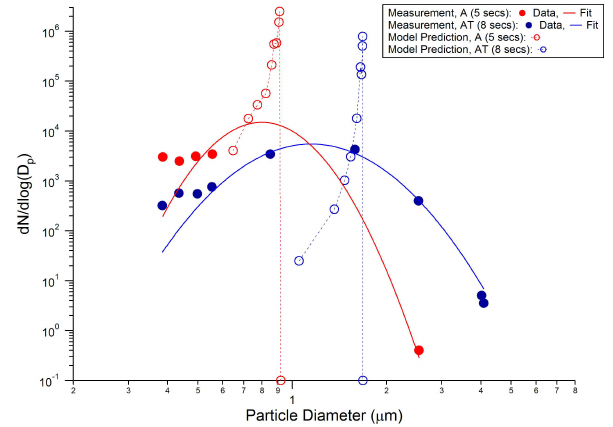
Fig. 2. Comparison of model predicted ice particle size distribu- tions with near-field measurement results reported in the paper by Schr¨oder et al.